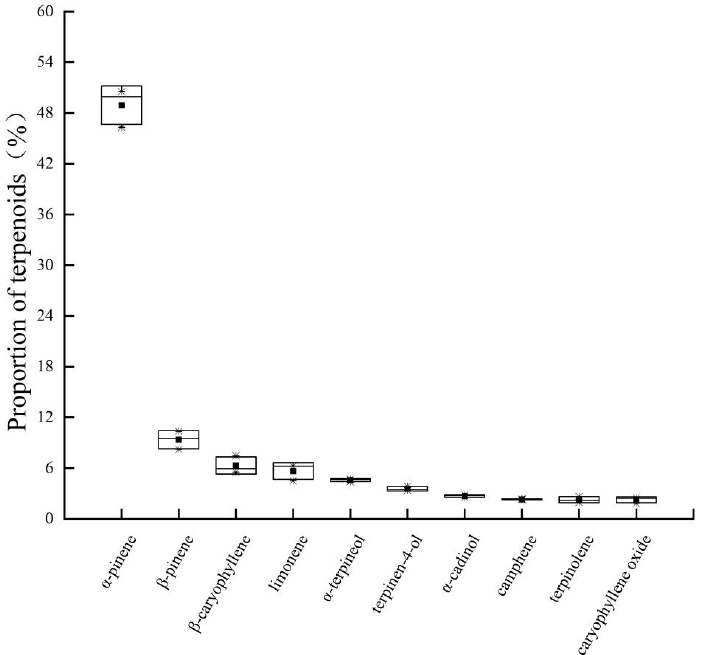
Figure 5. Ten most abundant terpenoids in volatile oil from surface dead fuel. (The top and the bottom lines in the boxes indicate the upper and the lower quartiles, respectively. The lines within the boxes indicate the median lines, and the solid square indicate the mean values).